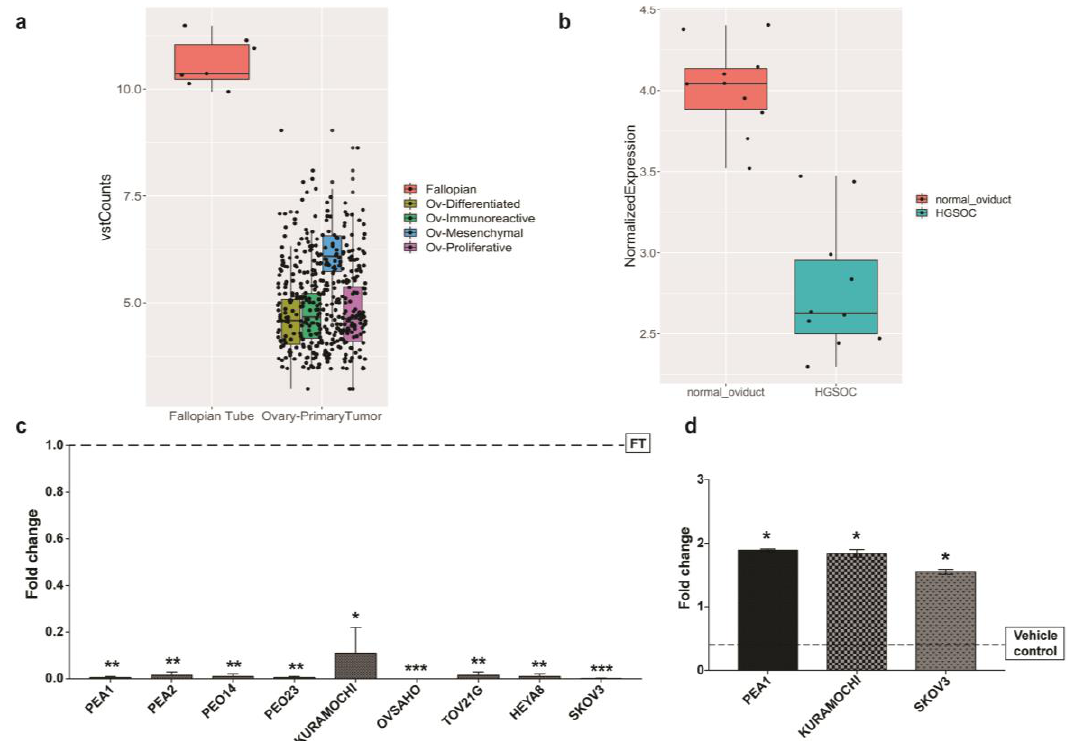
Figure 2. Analysis of long non coding RNA (lncRNA) HAND2-AS1 expression plotted as box plots between HGSC and FT tissues obtained from ( a ) The Cancer Genome Atlas–Ovarian Cancer (TCGA-OV) and Genotype Tissue Expression (GTEx-FT); ( b ) GSE69428; ( c ) Expression of HAND2-AS1 in several ovarian cancer (OC) cell lines with control as primary FT cells (FT); ( d ) Expression of HAND2-AS1 in KURAMOCHI, PEA1, and SKOV3 cells after 5-Aza-2’-deoxycytidine (5-AZA) treatment along with the corresponding vehicle control. Values from experiments (n = 2) are expressed as means ± SD from real-time PCR performed in duplicates normalized using house-keeping gene Abelson (ABL) expression. Student’s t-test (two-tailed) was used to calculate the p -value between control and test groups with the cutoff as p ≤ 0.05, wherein asterisks denote significance. * p < 0.05, ** p < 0.01, *** p < 0.001.